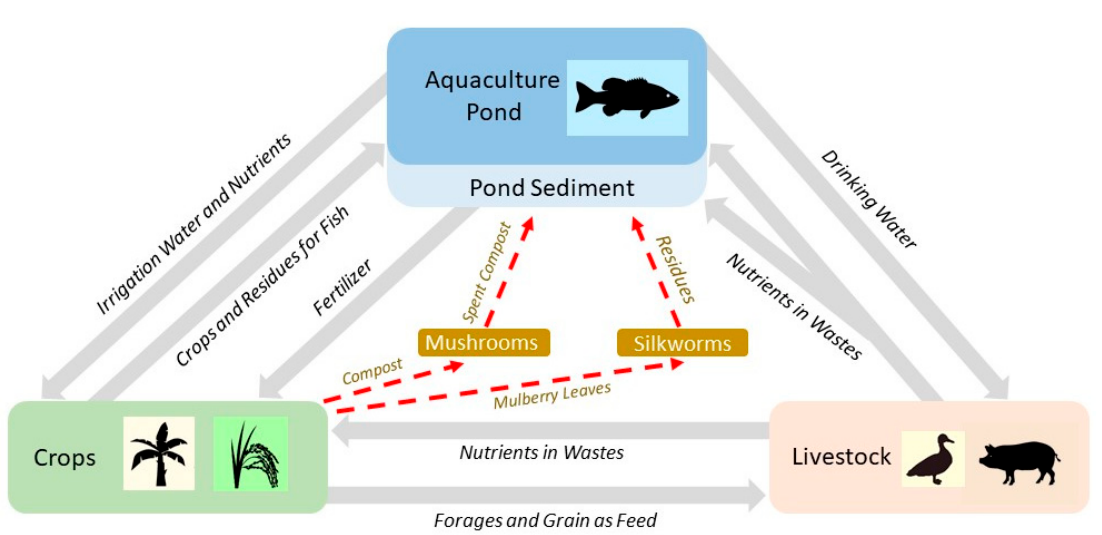
Figure 3. Schematic diagram of nutrient flows in integrated agriculture–aquaculture (IAA) systems involving fish, crops, and terrestrial farm animals. The flows of the generic system are depicted with gray arrows. Additional flows characteristic of the jitang system are indicated with dashed red arrows. For more detailed diagrammatic representations, see [156] and [182].